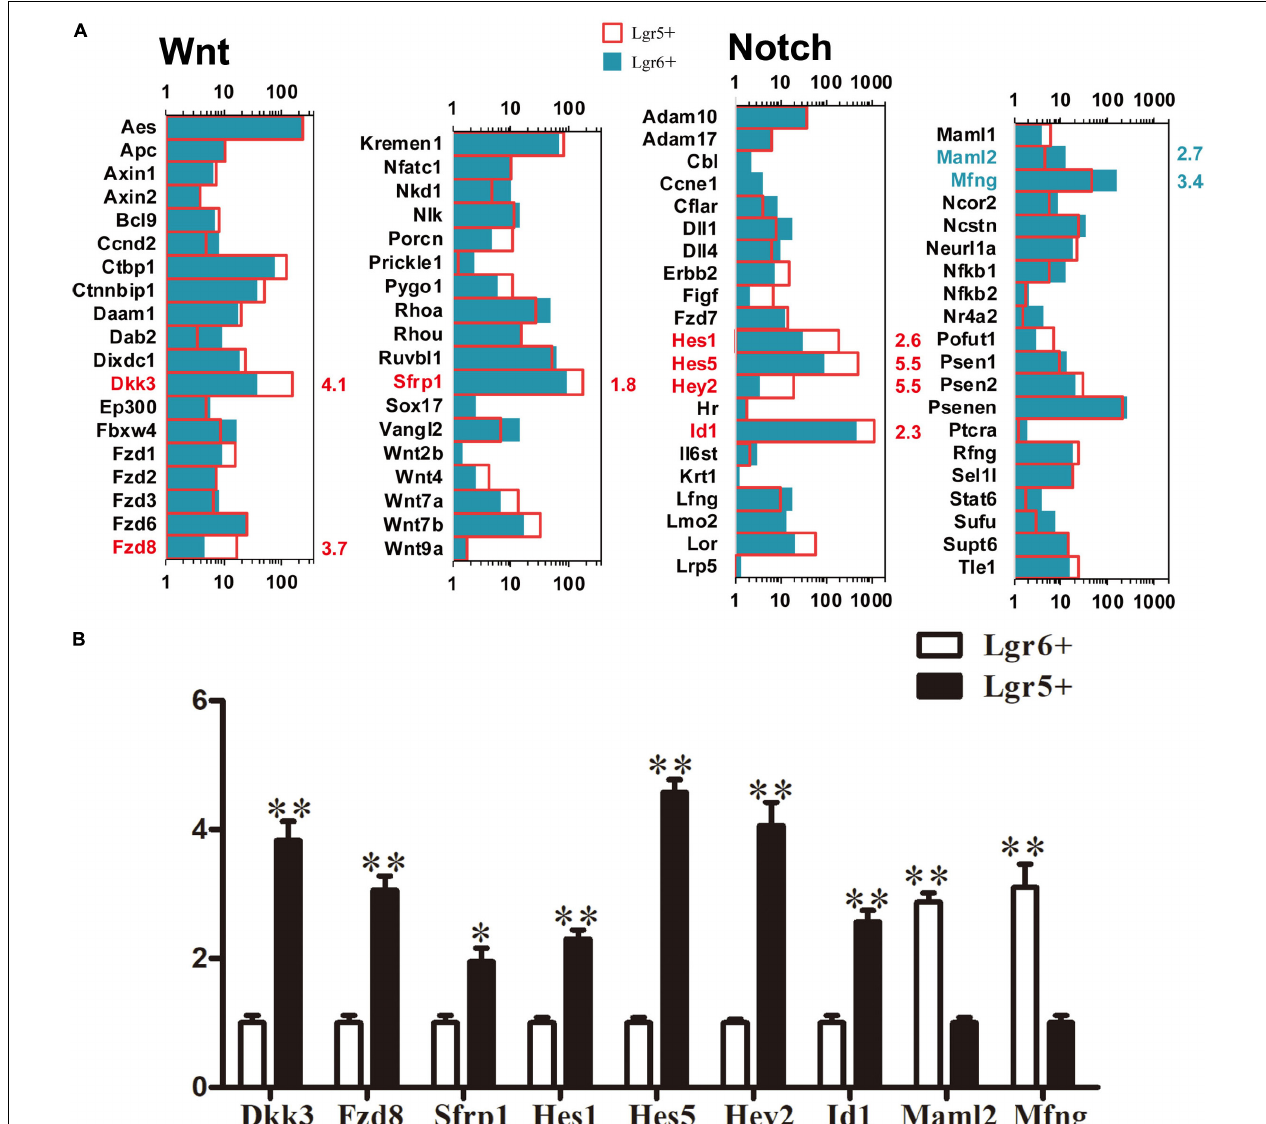
FIGURE 7 | Signaling pathway genes in Lgr5+ progenitors and Lgr6+ progenitors. (A) The differentially expressed genes in Lgr5+ progenitors and Lgr6+ progenitors that are involved in the Wnt and Notch signaling pathways. The significantly differentially expressed genes in Lgr5+ progenitors and Lgr6+ progenitors are labeled in red and blue, respectively. The number in red on the right of each panel represents the fold difference in expression in Lgr5+ progenitors versus Lgr6+ progenitors, and the number in blue on the right of each panel represents the fold difference in expression in Lgr6+ progenitors versus Lgr5+ progenitors. (B) q-PCR analysis of the Notch and Wnt signaling pathway genes. ∗∗ p < 0.01, n =